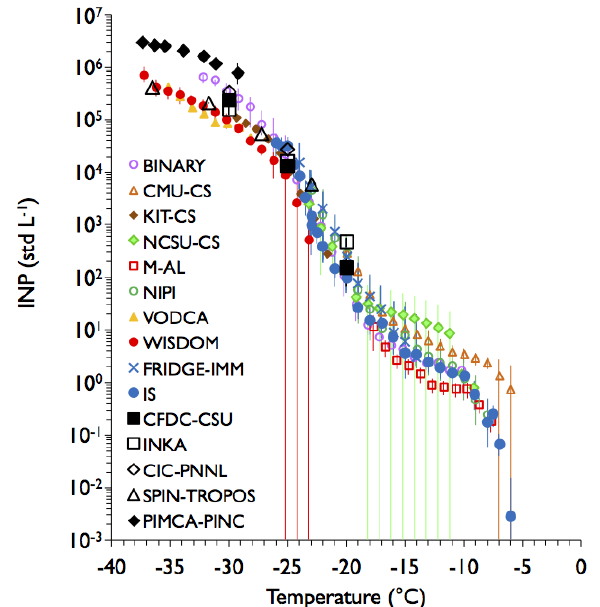
Figure 4. Combined results of all measurements of Argentinian soil dust sampled from the APC under conditions representative of those favoring immersion freezing nucleation in all devices. Note that most of the bulk immersion freezing data have been subsam- pled at ∼ 1 ◦ C intervals. These immersion freezing methods are distinguishable here by their smaller data points (using different symbols and colors) over a broad range of temperatures, whereas direct sampling devices using conditions supersaturated with re- spect to water (immersion freezing assumed as a major contributor) at specific temperatures are indicated by sparse (larger) black data points. The KIT-CS, NCSU-CS, NIPI, VODCA, M-AL, BINARY, and WISDOM instruments shared impinger samples, while the IS and FRIDGE-IMM used separate filter collections (distinguished here by blue data points). As discussed in the text and Eqs. (1)–(3), corrections have been applied to real-time instrument data depend- ing on the time of sampling, constituting a ratio of total particle concentrations present at the time of impingers/filter collections to those present at the time of specific flow chamber measurements. Error bars represent 95% confidence intervals, unless stated other- wise in the Supplement for each specific instrument. When error bars are not present, they may be subsumed within the marker (i.e., small errors) or alternately the binned point represents a single ob- servation. The data herein correspond to FIN-02 APC experiments 9 and 10 on 17 March